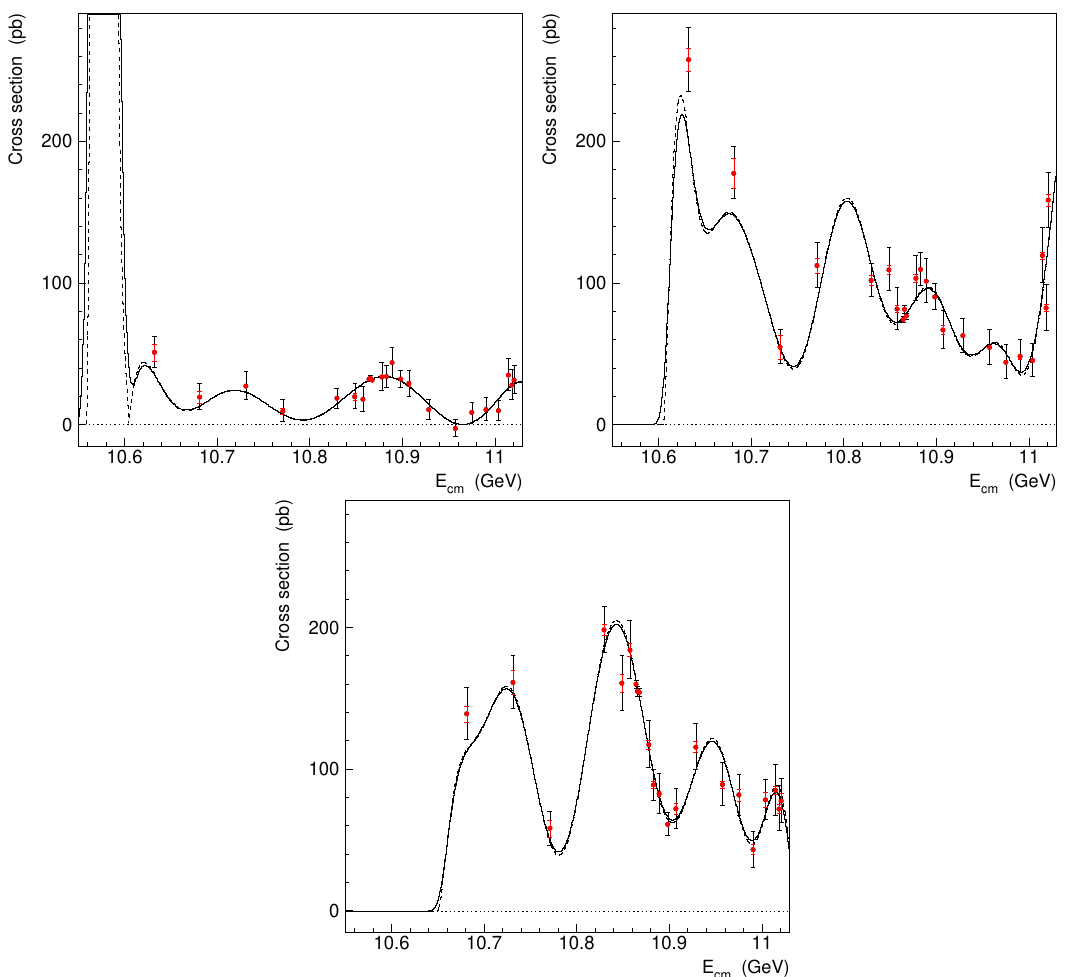
Figure 8 . Measured dressed cross sections at various energies for e + e − → B ¯ B (left), e + e − → B ¯ B ∗ (right), and e + e − → B ∗ ¯ B ∗ (bottom). The outer error bars indicate statistical uncertainties and inner red error bars indicate uncorrelated systematic uncertainties. Solid curves show the result of the simultaneous fit to these distributions and the total b ¯ b cross section energy dependence (figure 9). Dashed curves show the fit function before the convolution to account for the E cm